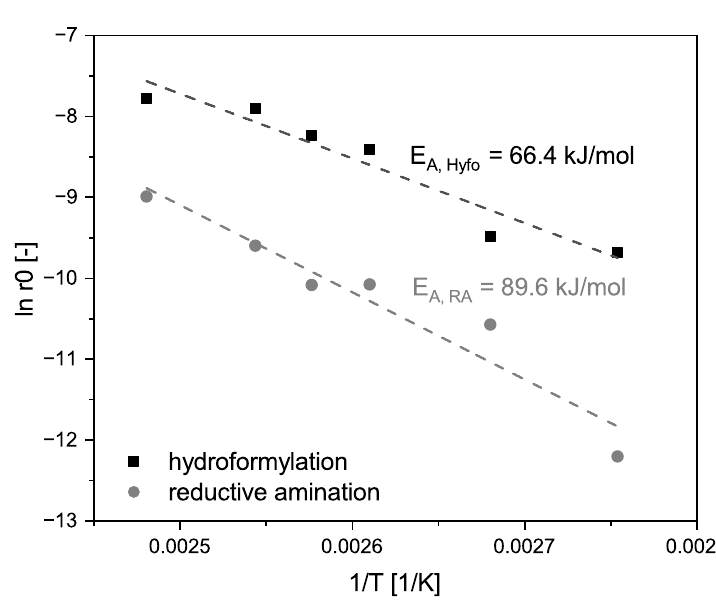
Figure 3. Arrhenius diagram for the substep hydroformylation and reductive